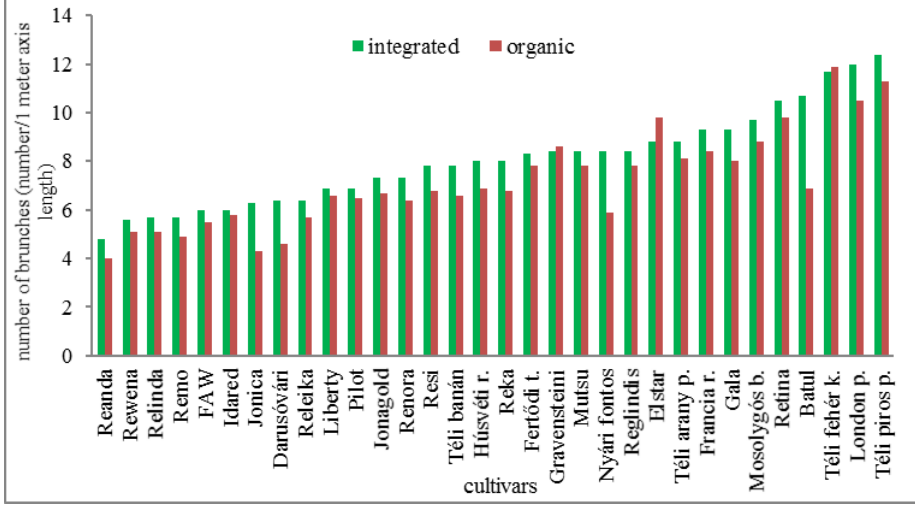
Figure 1. Number of branches per 1 meter axis length in environmentally friendly production systems (Debrecen-Pallag, 2010)